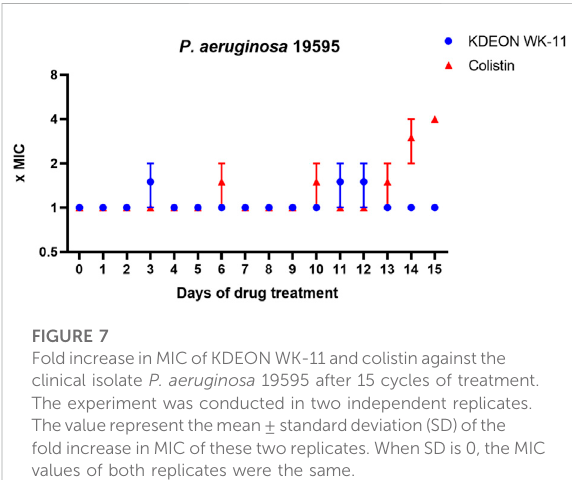
FIGURE 7 FoldincreaseinMICofKDEONWK-11andcolistinagainstthe clinical isolate P. aeruginosa 19595 after 15 cycles of treatment. The experiment was conducted in two independent replicates. Thevaluerepresentthemean±standarddeviation(SD)ofthe fold increase in MIC of these two replicates. When SD is 0, the MIC values of both replicates were the